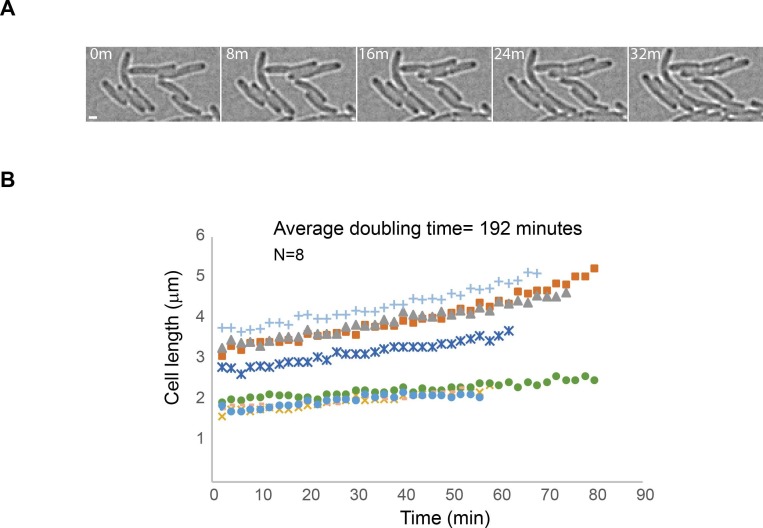
Minimal exposure to 405 nm activation light allows continuation of cell growth.(A) Images obtained from an sptPALM experiment of a strain carrying mMaple-DnaB using 2 s exposure times of the 561 nm laser and 2 min intervals (time in minutes). Note the growth of cells despite exposure to a single event of 405 nm wavelength activation and multiple exposures to 561 nm wavelength light. Scale bar = 2 µm. (B) Plot showing lengths of cells over time for eight different cells. The average of doubling-time is similar to the generation time of AB1157 at 22°C.